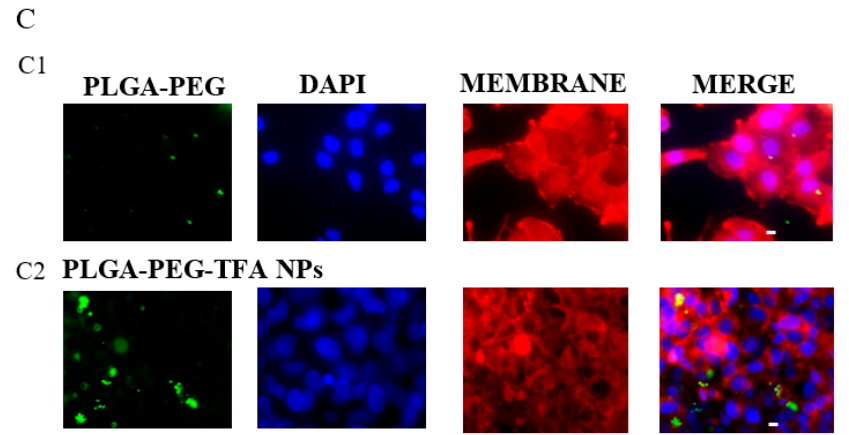
Figure 5. NP uptake assays. ( A ) PLGA-PEG NP and PLGA-PEG-TFA NP uptake assay characterized using an Odyssey Imaging System. Both types of NP were incubated with C28/I2 cells for 2, 4, 8, 24, 48, or 72 h. ( B ) Confocal microscopy images of cell membrane stained with DiD (red) (644 nm excitation, emission filter 670/40), nucleus stained with DAPI (blue) (365 nm excitation, 40 ms, emission filter 450/50) and FITC NPs (green) (490 nm excitation, emission filter 515). Images taken after 24 h of cell incubation with NPs. The images were taken with a Leica SP5C Spectral Confocal Laser Scanning Microscope. ( B1 ) Control sample (only cells with no NP treatment), ( B2 ) cells and PLGA-PEG-TFA NPs, and ( B3 ) cells and PLGA-PEG NPs. ( C ) Fluorescence microscopy images showing internalization of fluorescent PLGA-PEG and PLGA-PEG-TFA NPs. Visualization after 24 h of incubation with NPs in PBS. ( C1 ) PLGA-PEG NPs, and ( C2 ) PLGA-PEG-TFA NPs. Cell membrane stained with CD44-PE (red), cell nucleus with DAPI (blue) and NPs with NIR dye (green). The images were taken with a Leica fluorescence microscope at 43× magnification. Asterisks indicate significant difference in two-way ANOVA, ** p < 0.01 and **** p < 0.0001.